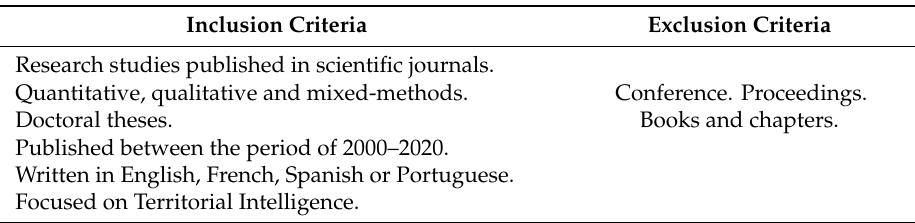
Table 1. Inclusion and exclusion